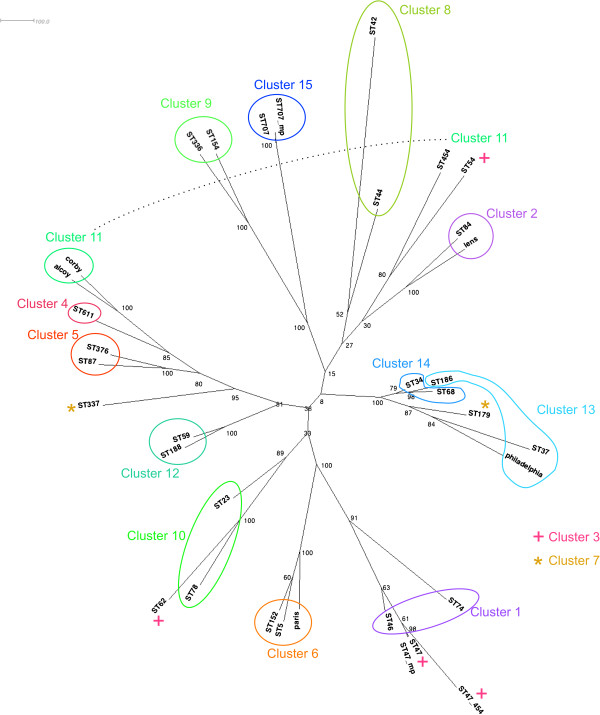
A maximum parsimony tree based on the presence and absence of genes in the 27 L. pneumophila genomes sequenced as part of this work and 5 additional genomes from GenBank (Alcoy, Corby, Lens, Paris, Philadelphia). The internal nodes are labelled with the bootstrap values.